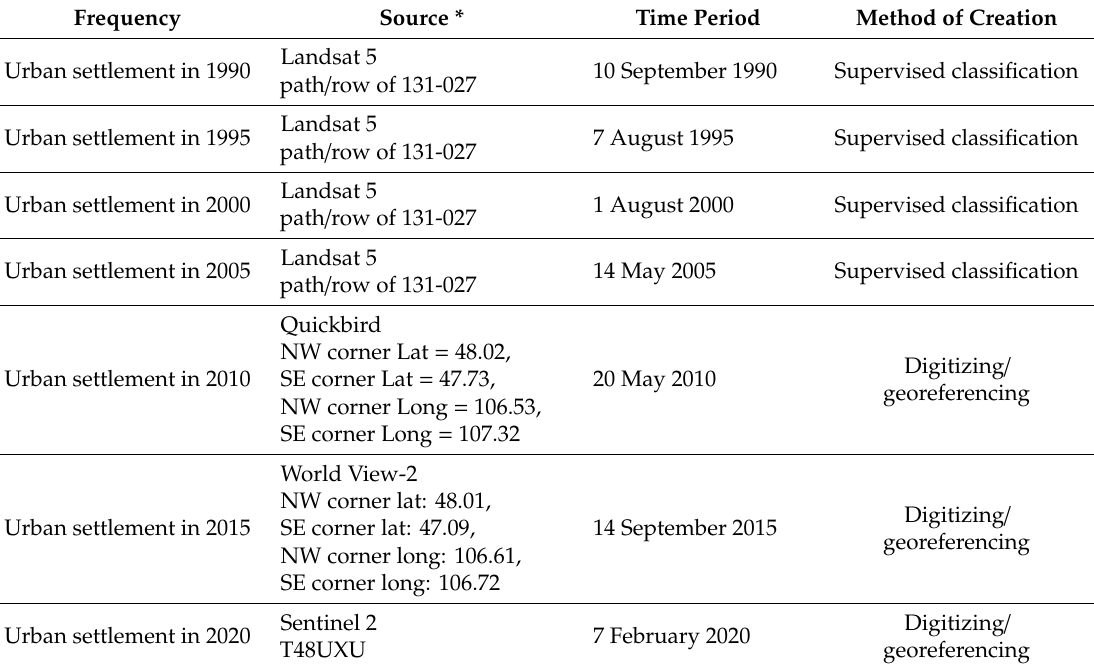
Table 1. Data source used to create urban settlement